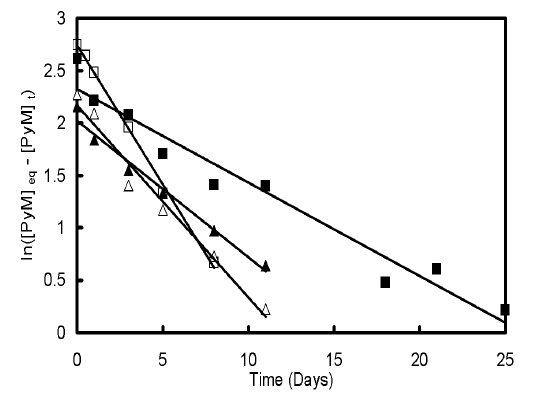
Figure 5. Analysis of the micellar solubilization kinetics of pyrene by arborescent polystyrene- graft -poly(2-vinylpyridine) copolymers. The following rate constants were obtained: Δ G0PS - P2VP5 - 12, k = (0.18  0.01) d −1 ; ▲ G1PS - P2VP5 - 13, k = (0.13  0.01) d −1 ; □ G1PS - P2VP5 - 20, k = (0.266  0.006) d −1 ; ■ G2PS - P2VP5 - 18, k = (0.089  0.007) d −1 . Reprinted from Reference 27 by permission from